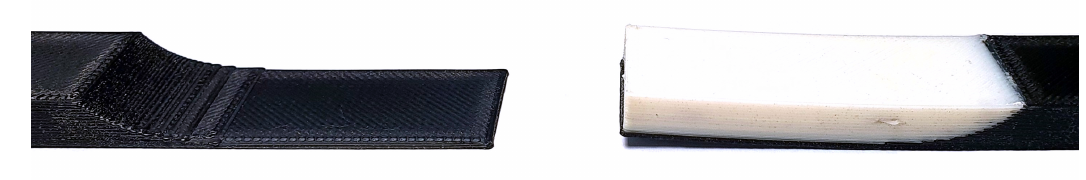
Figure 1. Tip of Acoustic Black Holes (ABH) beam with ( right ) and without ( left ) additional damping